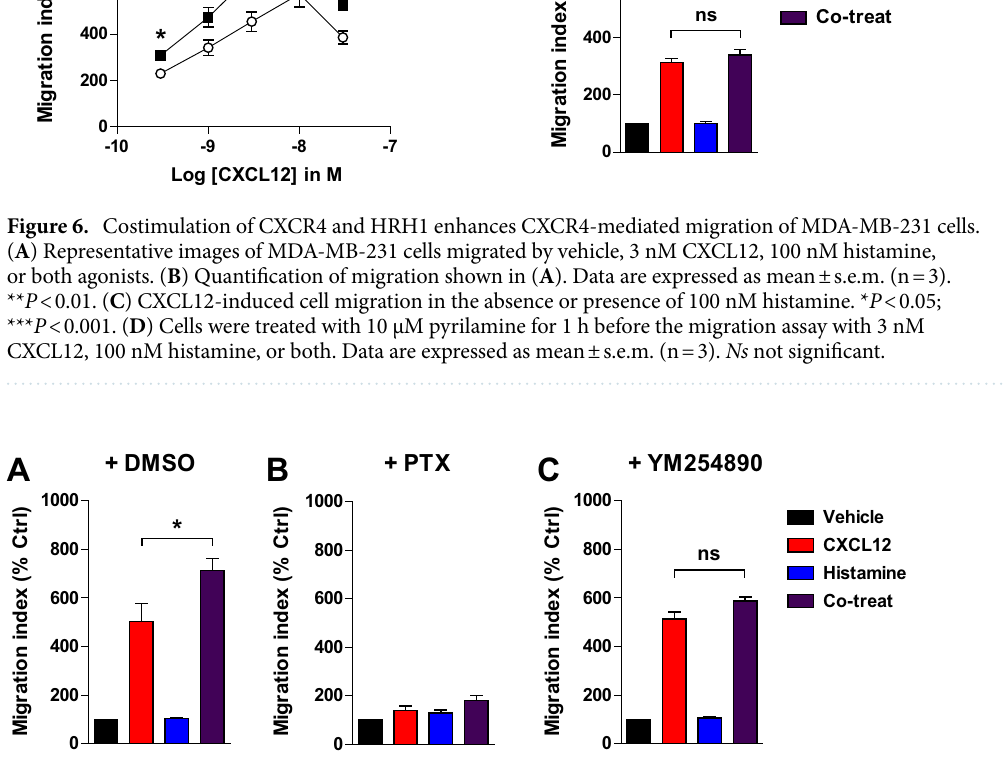
Figure 7. Gα i/o plays a fundamental role in CXCR4-mediated migration and Gα q/11 is responsible for enhanced cell migration induced by costimulation of CXCR4 and HRH1. Cells were treated with vehicle ( A ), PTX (100 ng/ml, overnight) ( B ), or YM254890 (300 nM, 30 min) ( C ) before the migration assay with 3 nM CXCL12, 100 nM histamine, or both. Data are expressed as mean ± s.e.m. (n = 3). * P < 0.05; ns, not